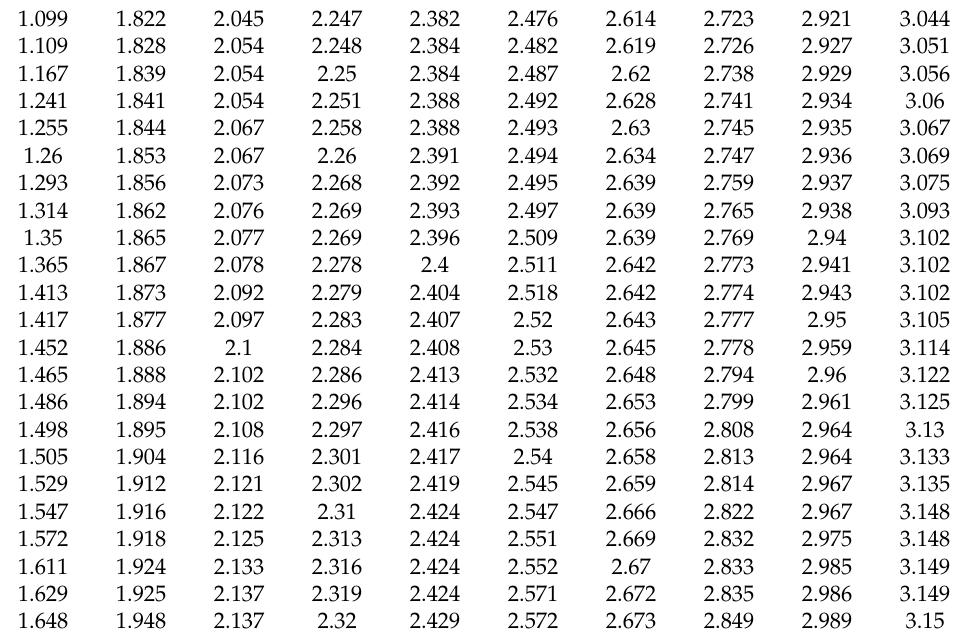
Table 5. The generated TIHC numerical